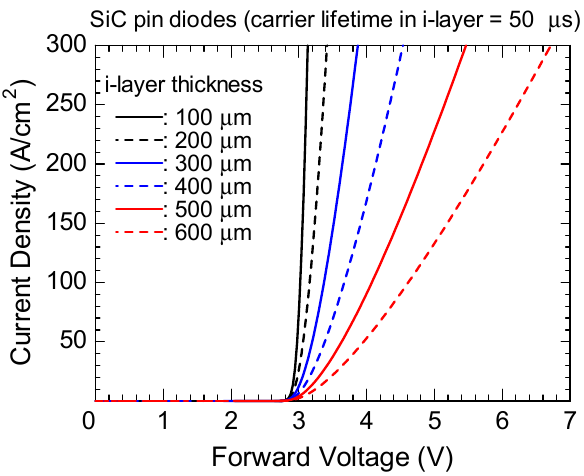
Figure 4. Forward characteristics of SiC pin diodes having different i-layer thicknesses from 100 µm (15 kV class) to 600 µm (65 kV class). Here the carrier lifetime was fixed at 50 µs.